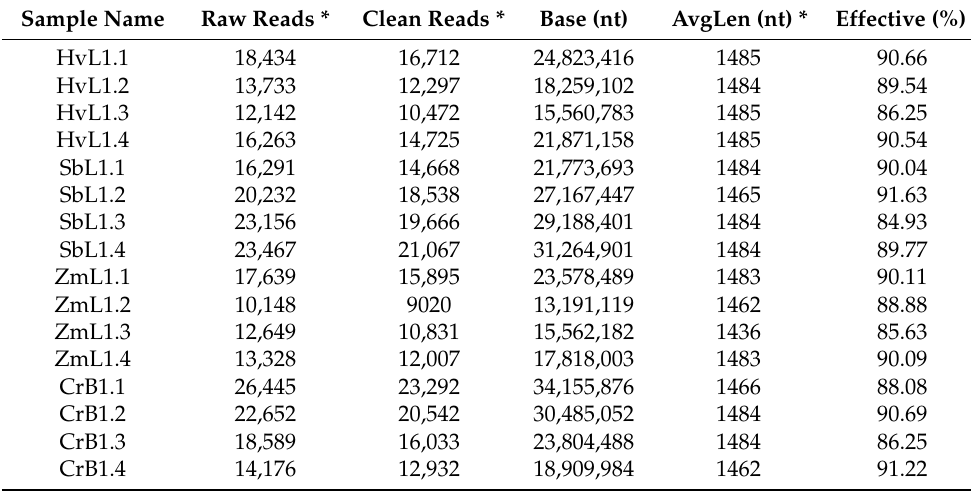
Table 1. Effective reads data for subsequent analysis after quality